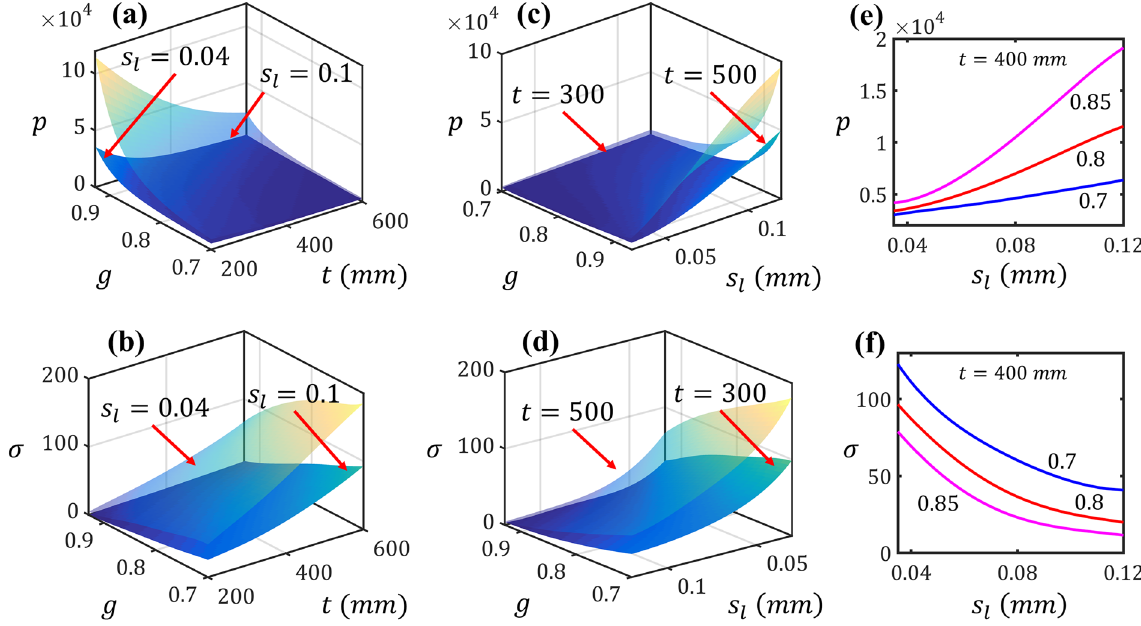
Figure 4. Effect of the characteristics of tissue samples (i.e., μ t g [ , , ] ) on the characteristics of scattering patterns (i.e, σ p [ , ] ): The effect on the transmittted power and the scaled Gaussian width are demostrated in the figures in, respectively, top and bottom rows. In ( a ) through ( d ), either t or μ is fixed and the outputs are plotted versus the other two inputs. In ( e ) and ( f ), p and σ are plotted versus μ for three values of g while having t fixed to 400 mm